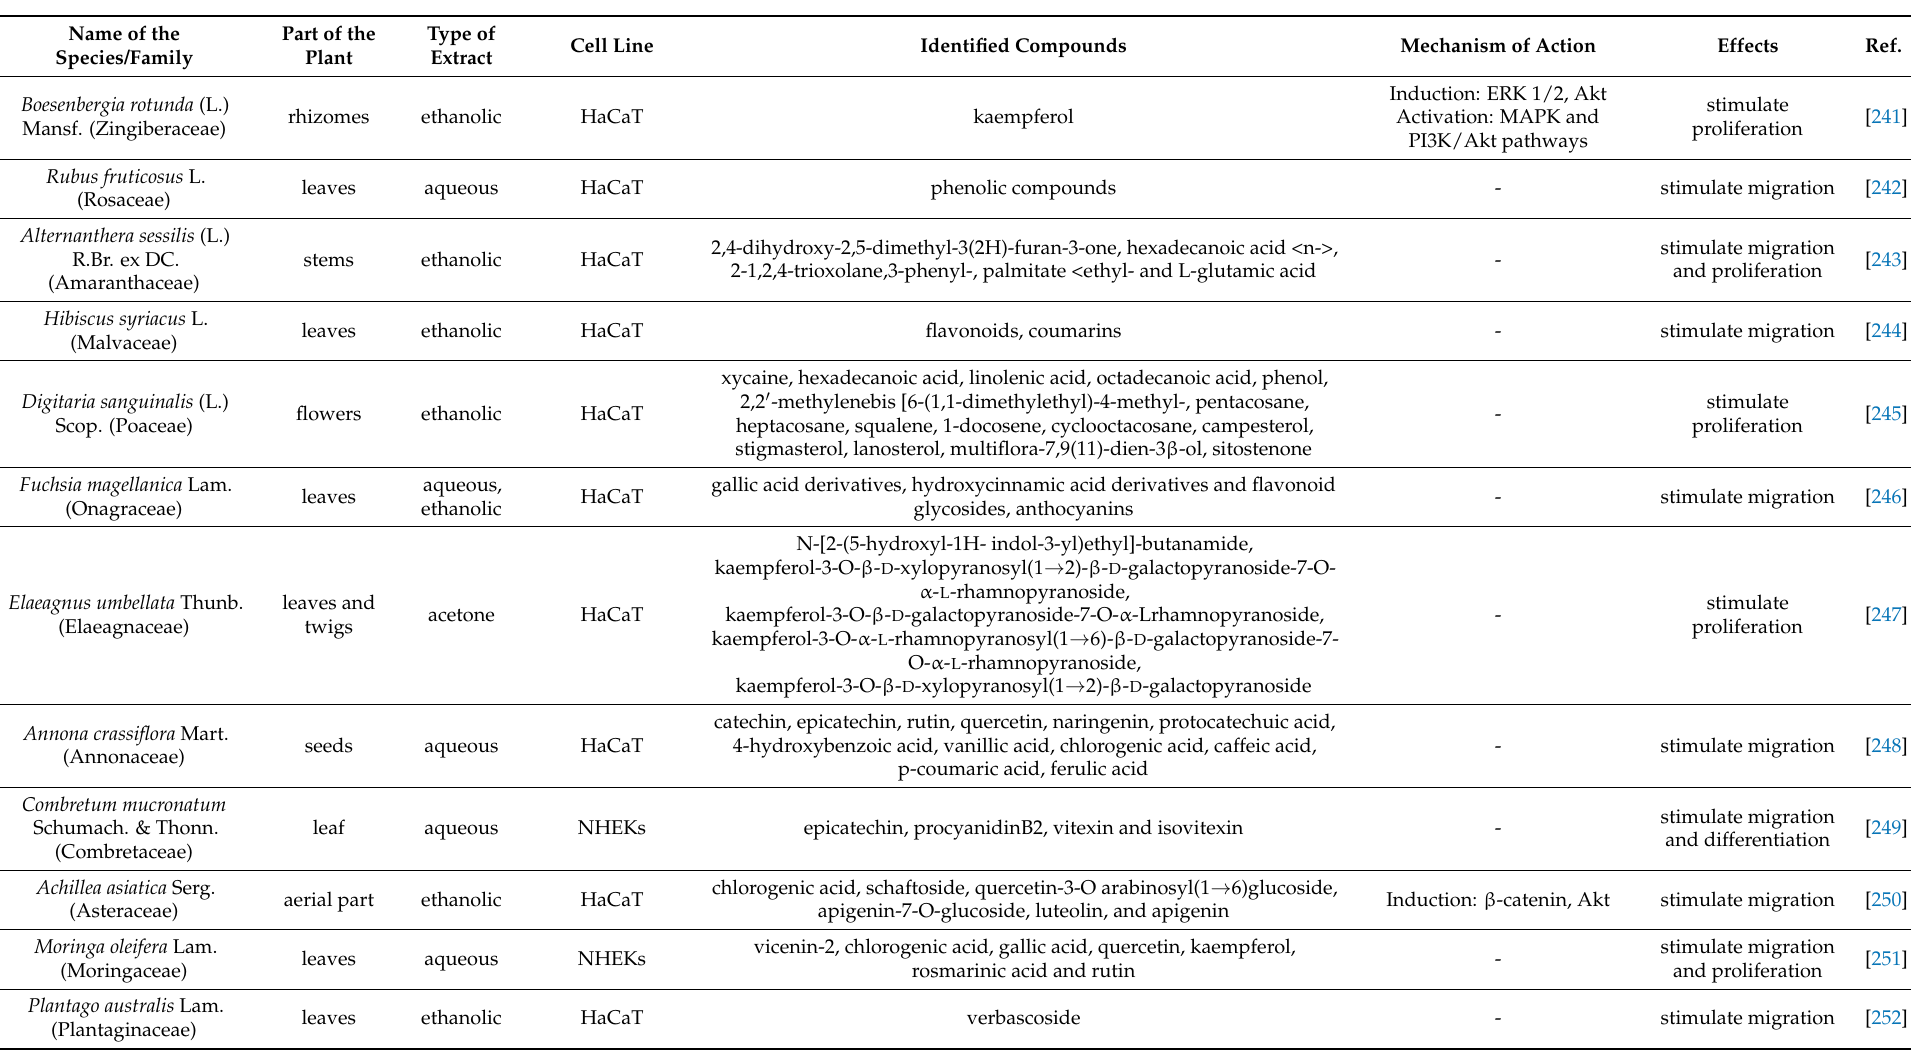
Table 4. Selected plant extracts from different species with identified compounds and their in vitro effect on human keratinocyte migration and proliferation